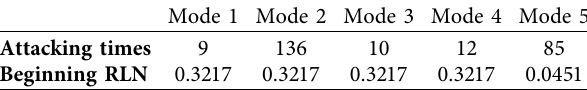
Table 2: Attacking times and beginning RLN of 5 modes.